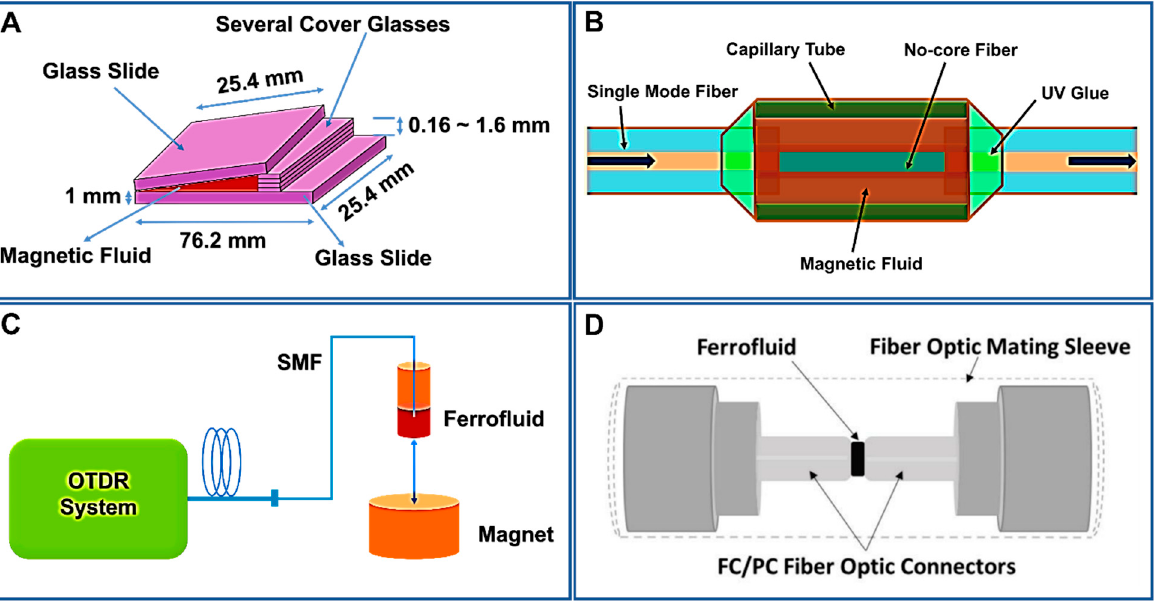
Figure 5. ( A ) Schematic illustration of the V − shaped groove. Adapted with permission from Ref. [69]. Copyright 2012, OPTICA Publishing Group; ( B ) schematic diagram of the FN − based magnetic field sensor. Adapted with permission from Ref. [71]. Copyright 2013, OPTICA Publishing